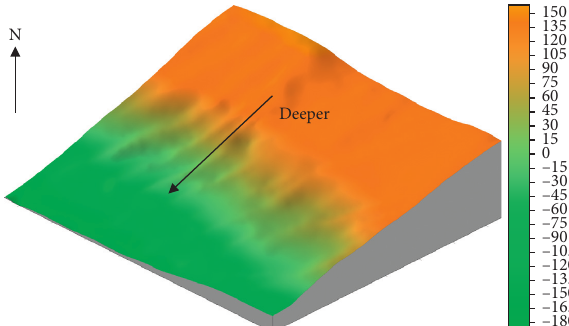
Figure 7: Top surface structure of Chang